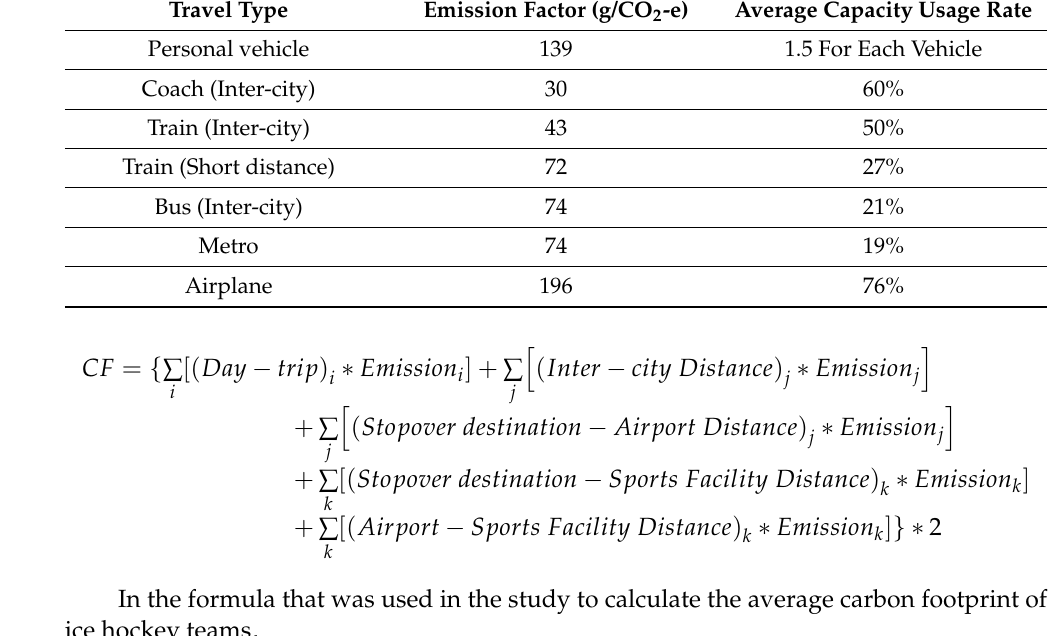
Table 2. The emission factors and the average capacity utilization rate according to the vehicle type. Travel